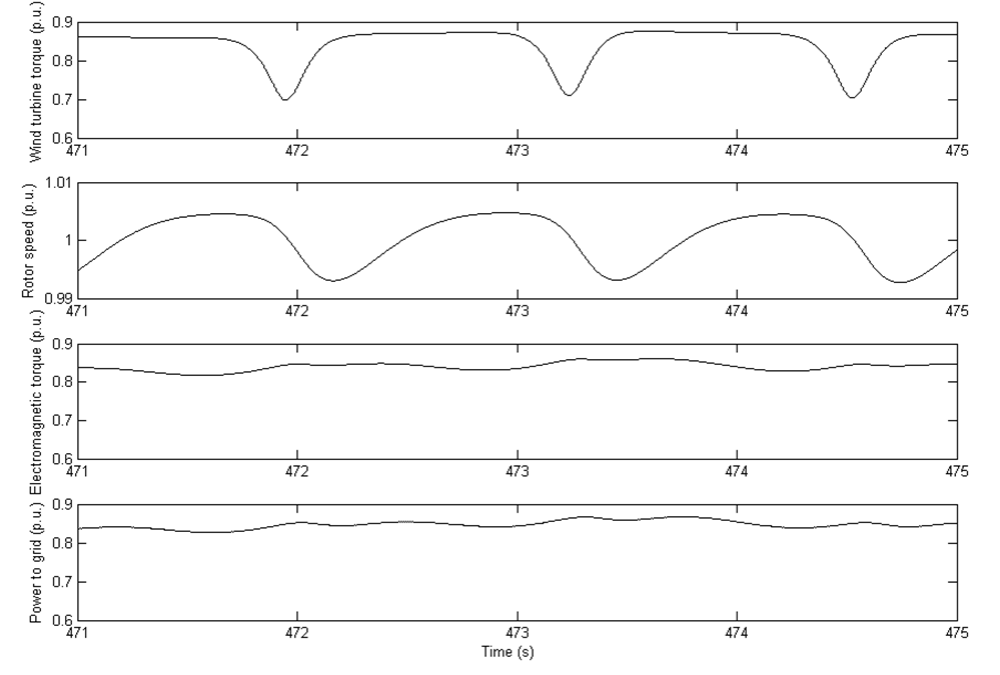
Figure 8. Short-term view of the wind turbine torque, the generator rotational speed, the electromagnetic torque and the active power to the grid.